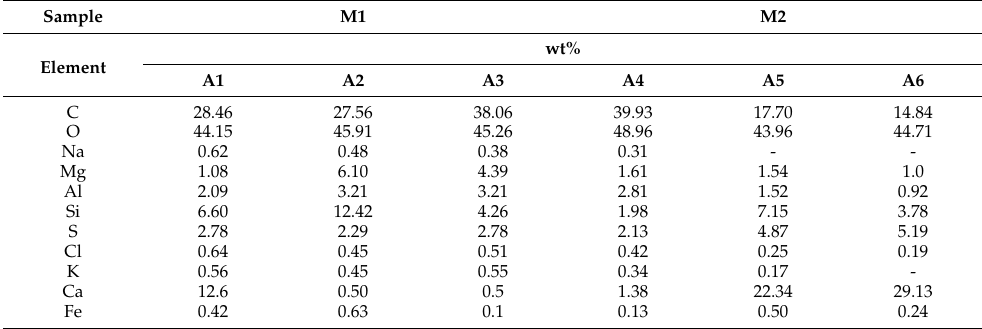
Figure 3. Blue pigment micrographs showing localized areas for EDS analysis and size classes: ( a ) M1 blue, and ( b ) M2 blue. Table 2. Elemental composition (%) determined through EDS of the blue